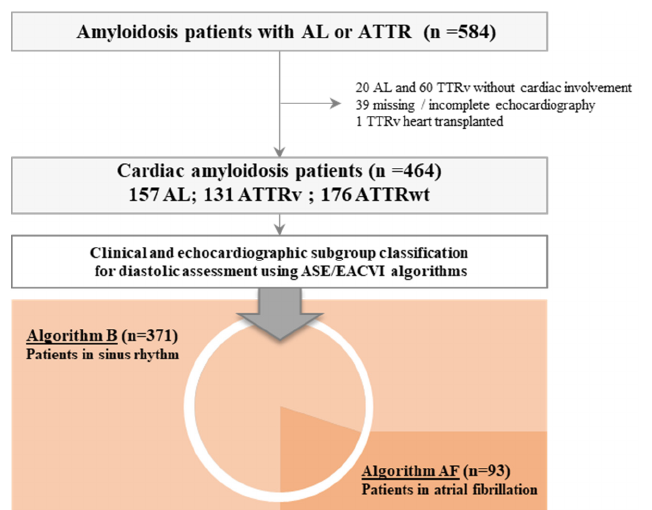
Figure 1. flow chart. AF: atrial fibrillation; AL: light chain amyloidosis; ATTR: transthyretin amy- loidosis, v: hereditary (variant); wt: wild-type.